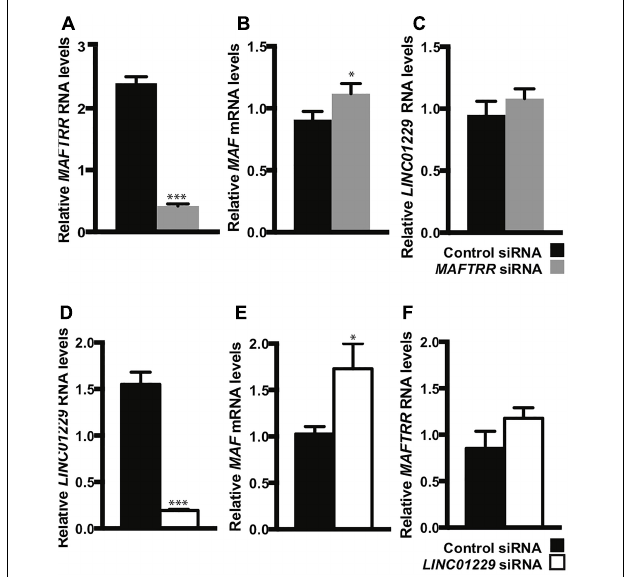
FIGURE 6 | Depletion of lincRNAs increases MAF mRNA levels in HEK293 cells. HEK293 cells were reverse-transfected with a control siRNA, 5 nM MAFTRR siRNA (A–C) or 5 nM LINC01229 siRNA (D–F) , and quantitative PCR was performed on RNA collected at 48 h post-transfection. (A) MAFTRR RNA transcript levels. (B) MAF transcript levels. (C) LINC01229 RNA transcript levels. (D) LINC01229 RNA transcript levels. (E) MAF RNA transcript levels. (F) MAFTRR transcript levels. Data represent four biological replicates; statistical significance was determined using unpaired t -test with one tail. Error bars denote standard error of the mean and asterisks indicate significance: ∗ p < 0.05; ∗∗∗ p <